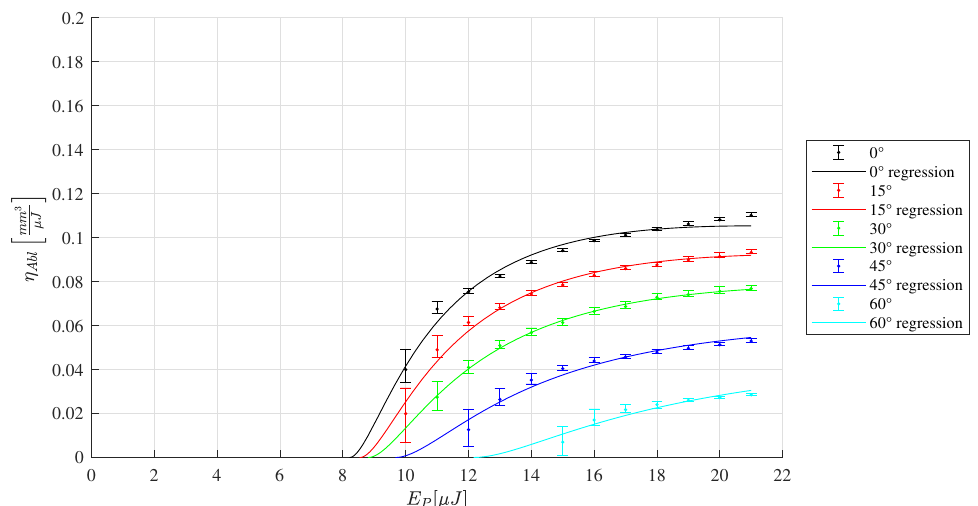
Figure 10. Ablation efficiency according to the depth measurement of the ablated of HTZ 500 LC samples for a range of inclination angles from 0 ◦ to 60 ◦ . The corresponding ablation model according to [13] leads to the parameters F th (0 ◦ ) = 1.29 Jcm –2 and δ (0 ◦ ) = 357nm.